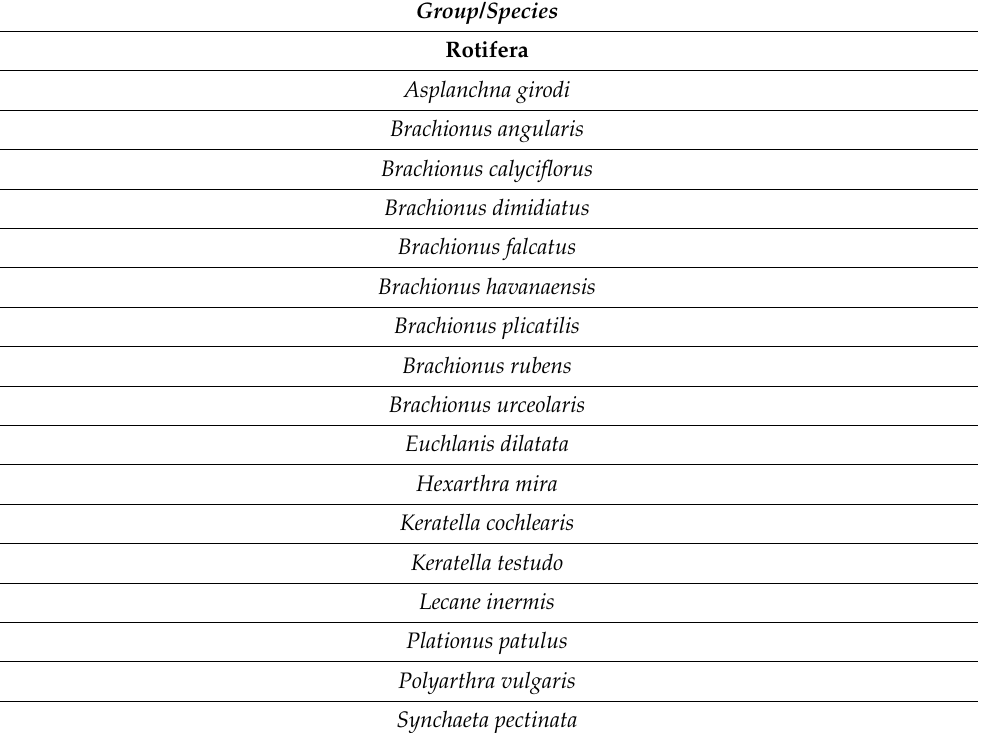
Table 2. Species of major zooplankton groups (Rotifera, Cladocera, and Copepoda) used in experi- mental studies with